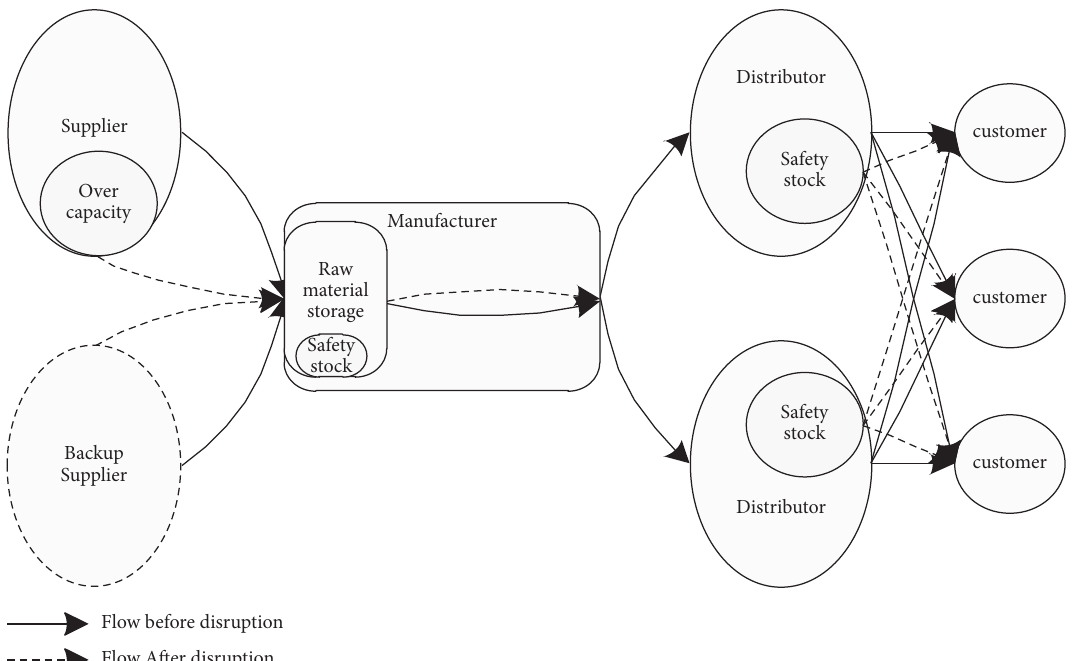
Figure 1: The supply chain